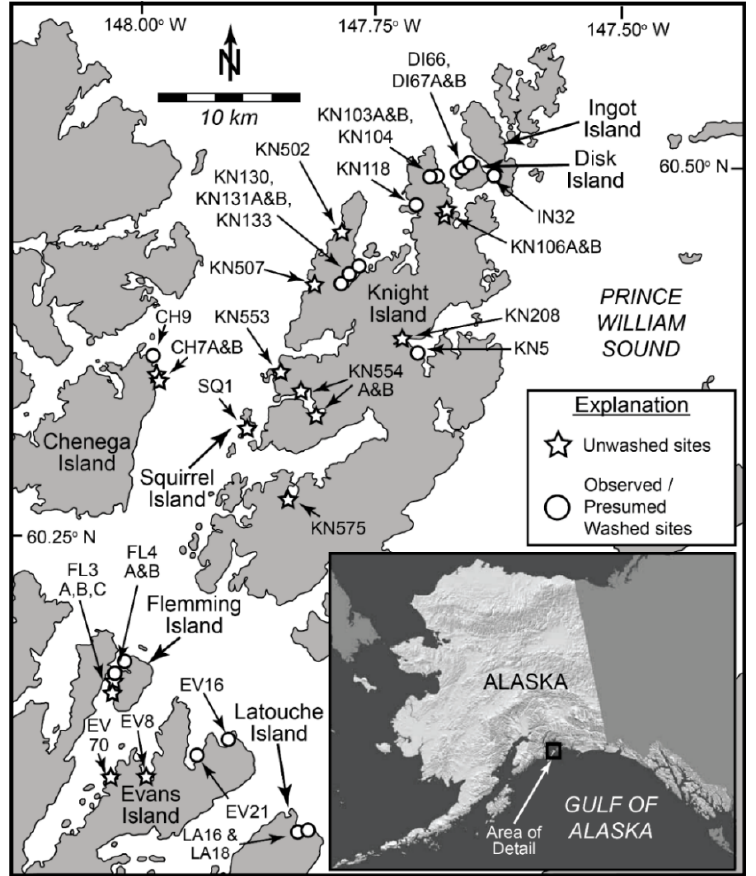
Figure 2. Study area: western Prince William Sound, Alaska (USA) with symbols identifying locations of beaches used in the development of our organization metric. Stars indicate beaches that were unwashed whereas circles indicate beaches which likely underwent manual disturbance through high-pressure/hot-water (HP/HW) washing following the 1989 Exxon Valdez Oil Spill. Data from the latter are used in our case study application of the organization metric. Inset from Riehle et al.